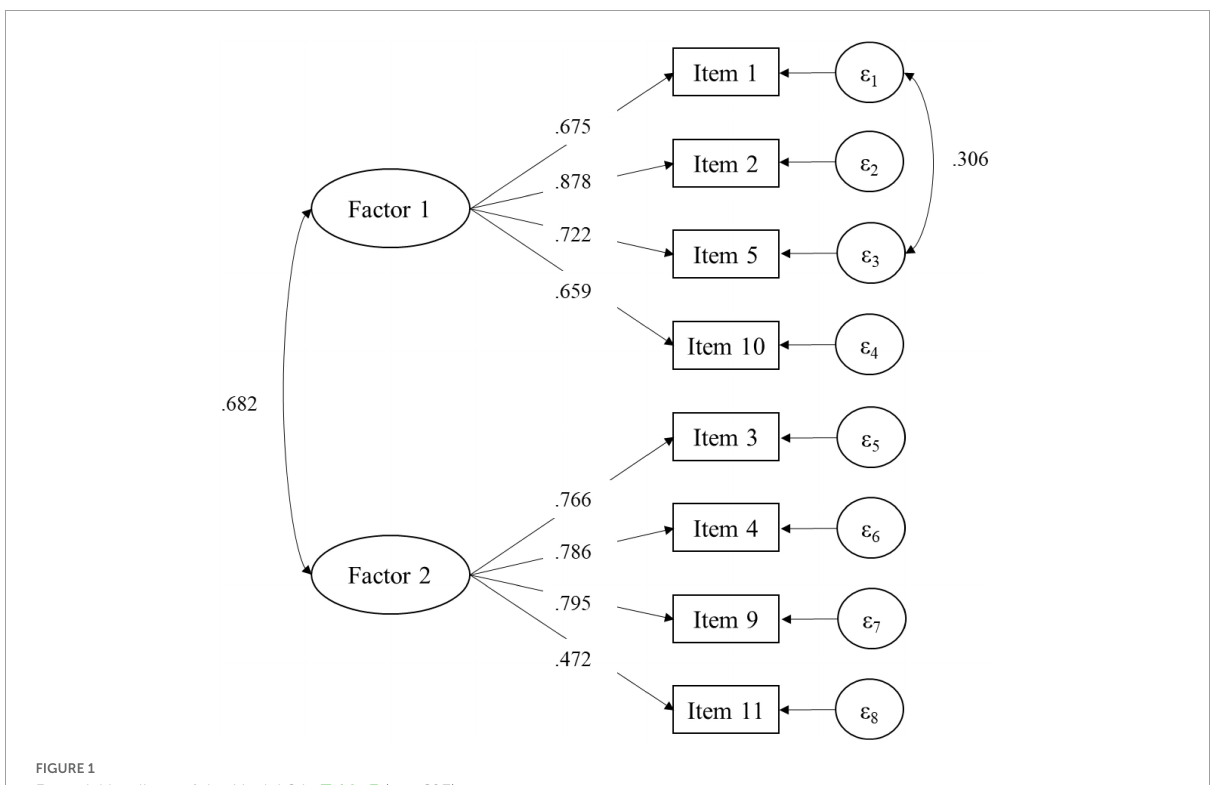
FIGURE1 Factorial loadings of the Model 8 in Table 3 ( n = 693).